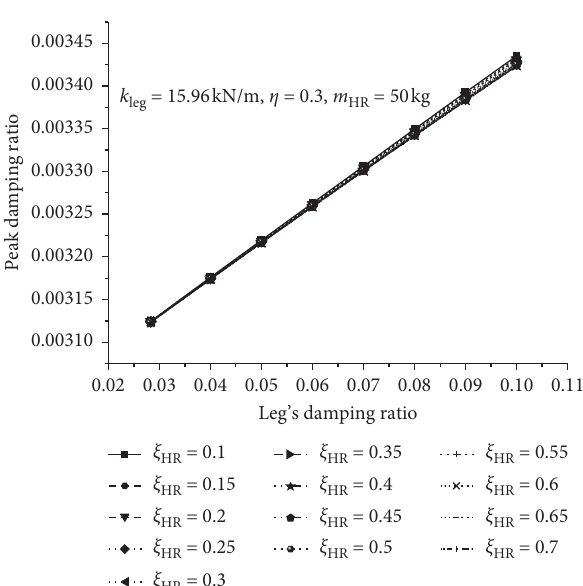
Figure 15: Peak damping ratio of structure under leg stiffness 15.96kN/m, η � 0 . 3, m